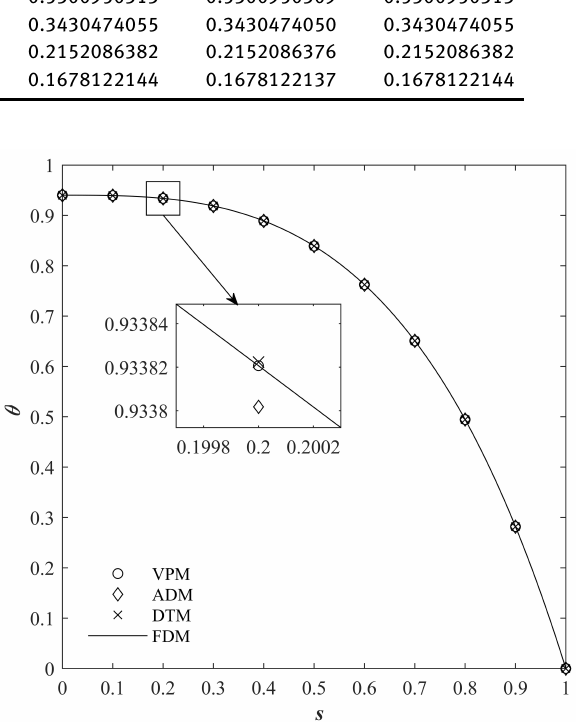
Fig. 2: Comparison of the solutions to equation (26) using all meth- ods